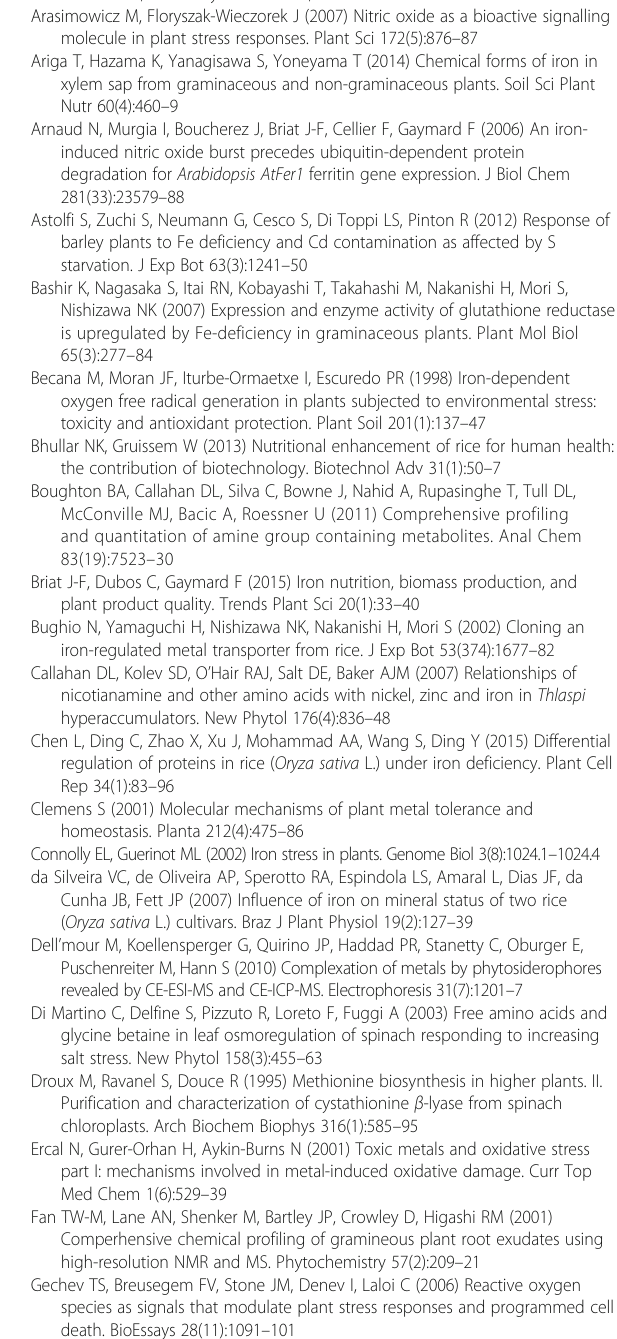
Additional file 1: Table S1A. Iron deficiency induced gene expression detected by qRT-PCR. Table S1B . Diurnal pattern of Fe deficiency induced gene expression detected by qRT-PCR. (DOCX 21 kb) Additional file 2: Table S2A. Amines concentrations from Fe-sufficient and Fe-deficient rice roots. Table S2B . Iron deficiency associated induction of root amines concentrations. (DOCX 38 kb)